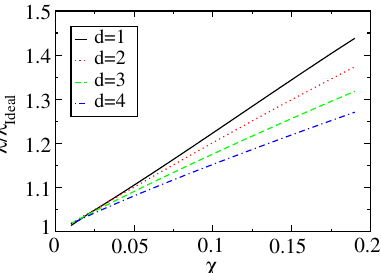
FIG. 12. Upper bounds on the mean nearest-neighbor distance λ , scaled by λ [cf. Eq. (91)], as a function of χ for the first four ideal space